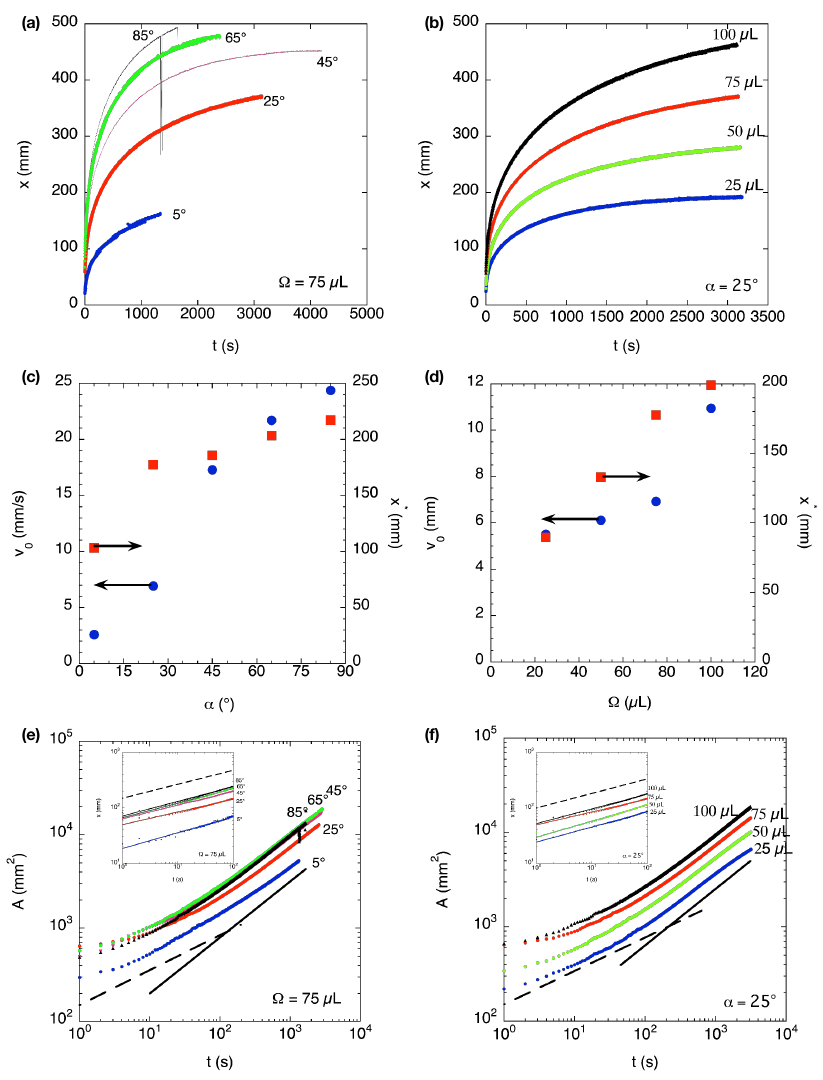
Figure 5: Silicone oil – (a)-(c)-(e) concern data taken for a fixed volume Ω of the droplet equal to 75 µ L, for five angles of inclination α =5, 25, 45, 65 and 85 ◦ (see legend). For (b)-(d)-(f), the angle was fixed at α = 25 ◦ for four droplets with volumes Ω =25, 50, 75 and 100 µ L (see legend). (a) and (b): Position of the tip of the oil stain. (c) and (d): Initial speed v 0 and characteristic length x (cid:63) . (e) and (f): Evolution of the area of the oil stain. The solid line is a power law fit, A ∝ t 0 . 6 , while the dashed line is for A ∝ t 0 . 37 . The insets (e) and (f) correspond to close-ups of x ( t ) in a log-log plot between t =1 and 100 s. The dashed lines correspond there to x ∝ t 0 . 26